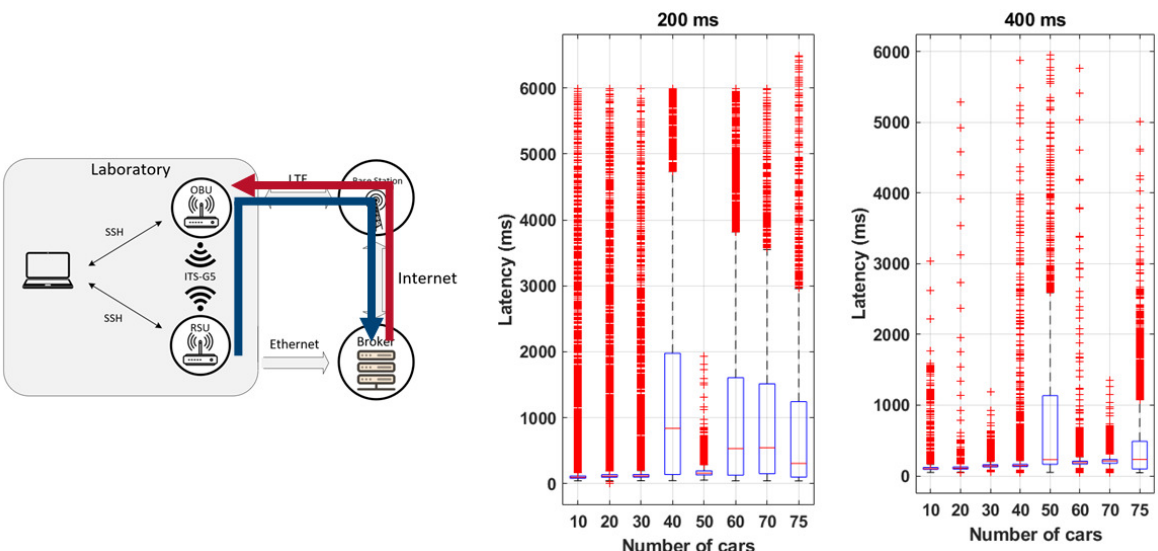
Figure 21. Latency values for 200 ms and 400 ms dissemination intervals when both ITS-Ss use LTE technology.